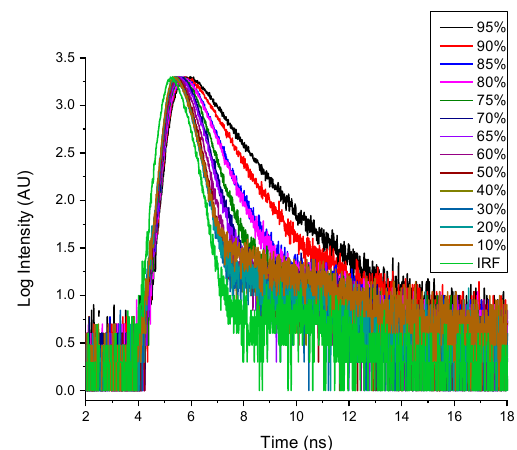
Figure 3. Fluorescence decay of dU-BZ recorded as a function of viscosity in glycerol/methanol solution; percentage indicated is the content of glycerol in solution.